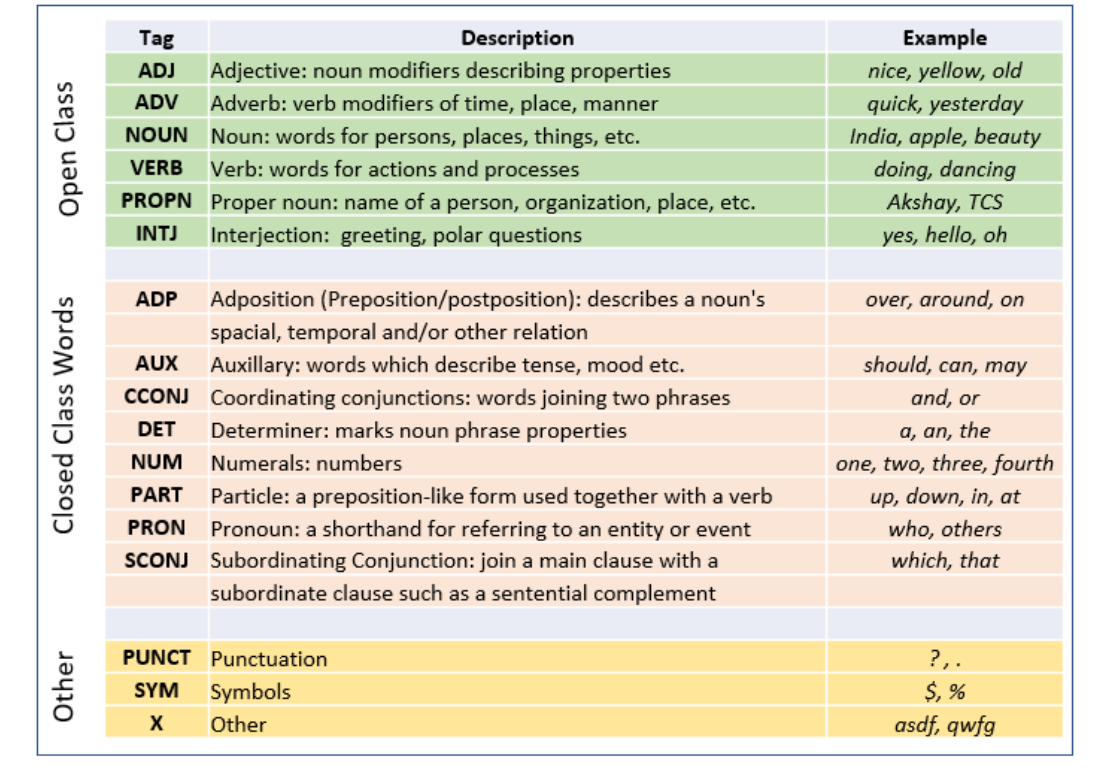
Figure 1. Universal Dependencies (UD) tagset by [34].